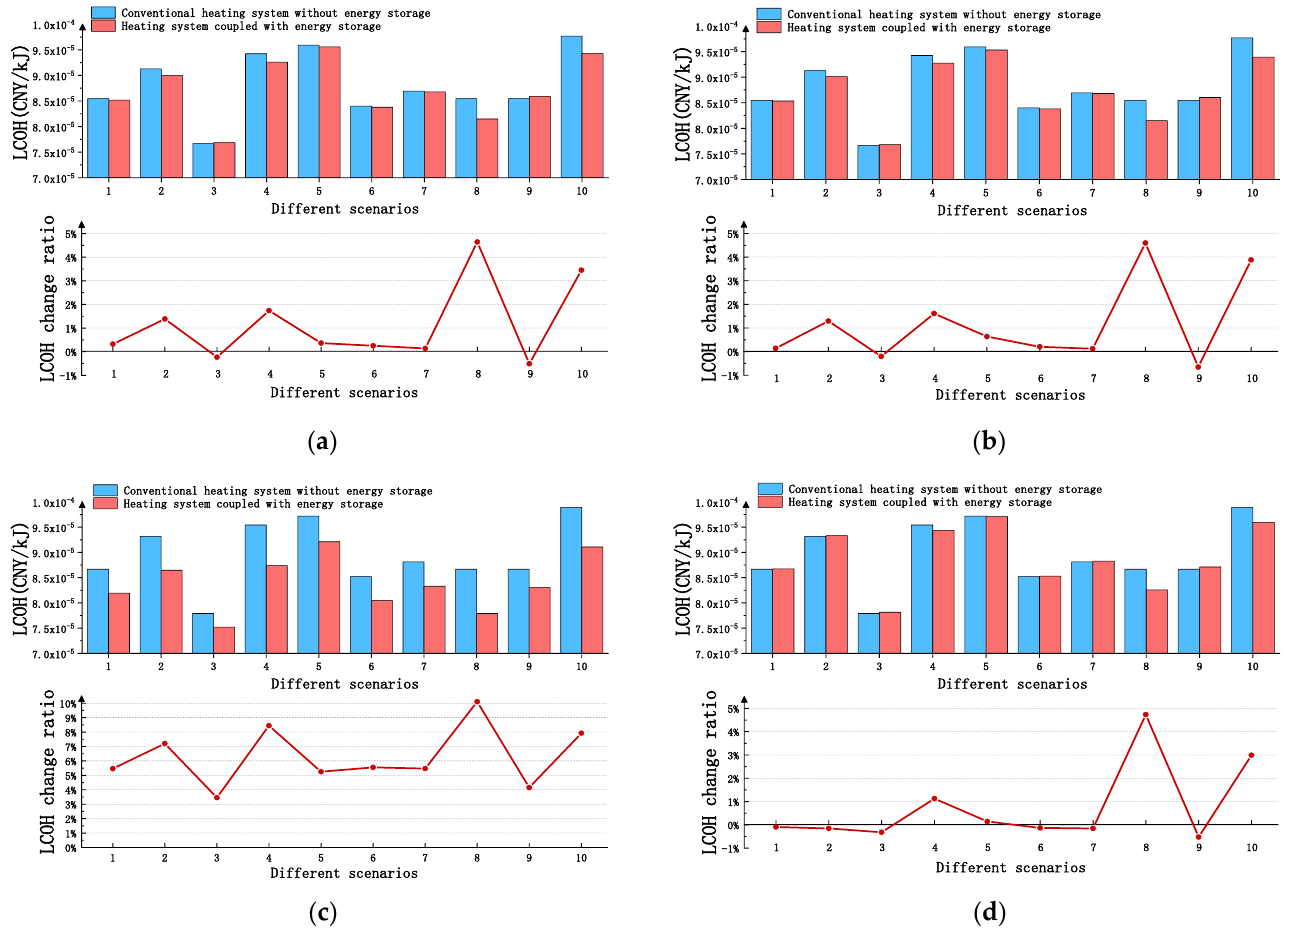
Figure 9. Minimum LCOH of each scenario: comparison between the conventional heating system and the heating system coupled with energy storage: ( a ) Case 1; ( b ) Case 2; ( c ) Case 3; ( d ) Case 4. CNY can be converted into USD based on CNY 1 = USD 0.1496 on 1 June 2022.